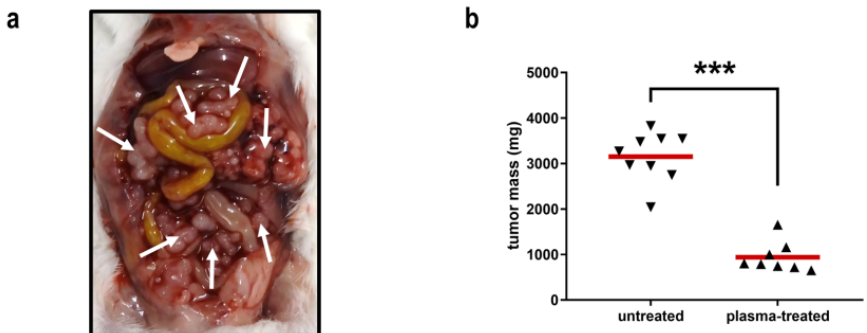
Figure 16. Efficacy of the repeated intraperitoneal administration of PTS (NaCl, kINPen argon plasma jet) against syngeneic, orthotopic and disseminated colorectal in mice ( a ) and its absolute tumor weights ( b ). Each triangle represents one mouse. *** p < 0.001. Reproduced from [40]. Copyright 2019 Springer Nature.